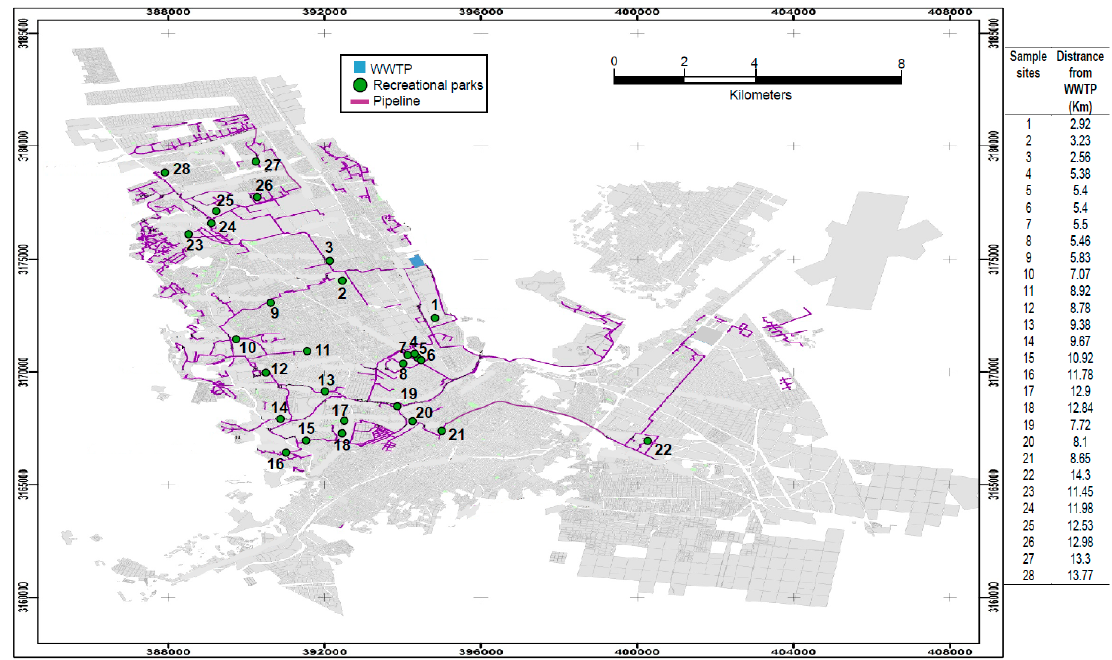
Figure 1. Sample sites (from Briones [26]). Recreational parks (green points) in the city of Chihuahua in Mexico irrigated by reclaimed wastewater (purple line = pipeline) from wastewater treatment plant (WWTP = blue square).